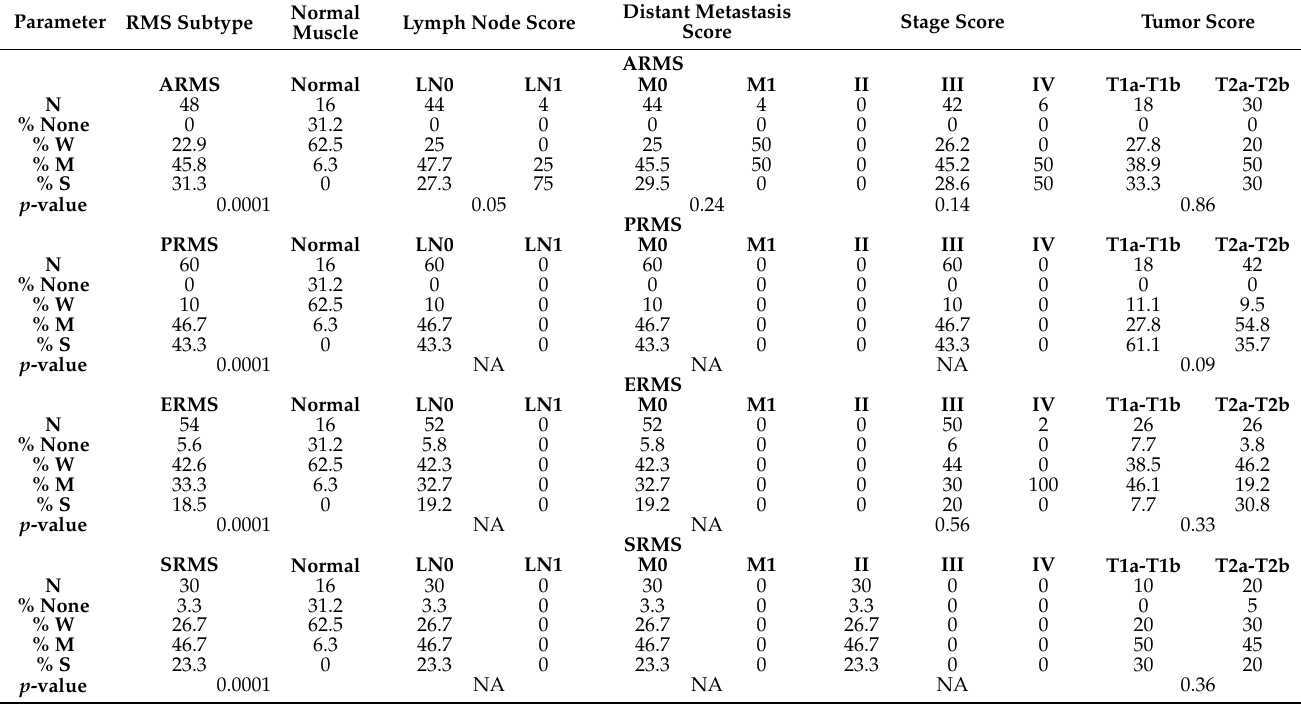
Table 2. Correlation of BiP protein expression with the clinicopathological features of RMS subtypes.